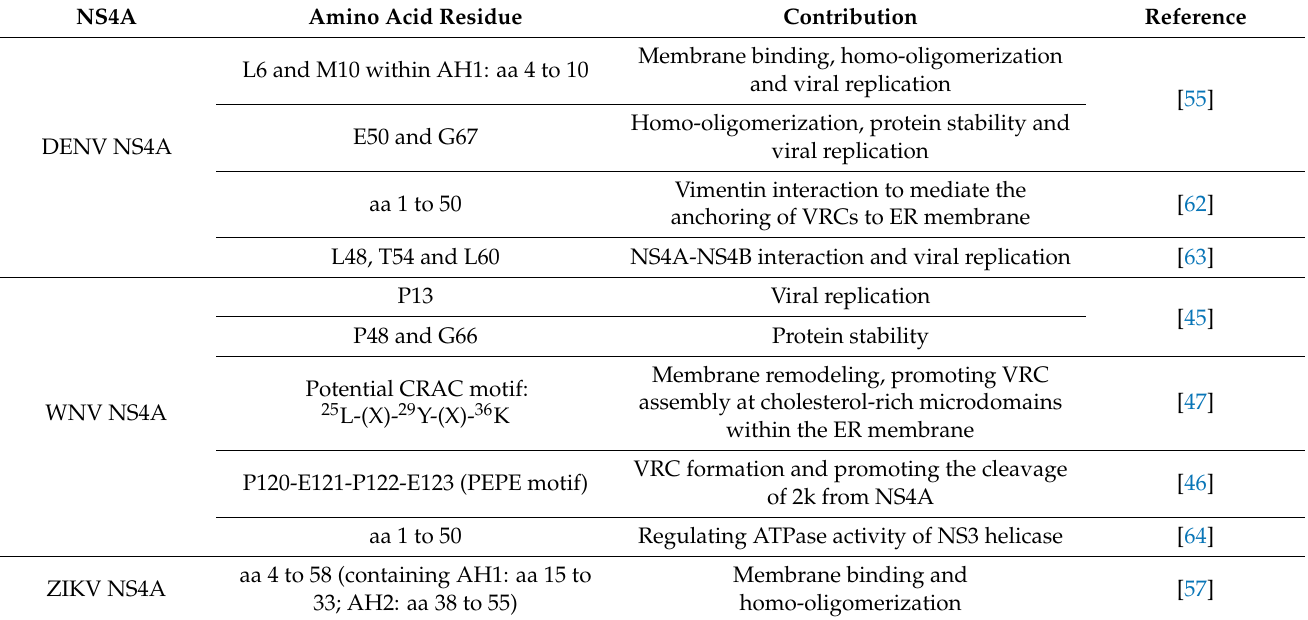
Table 1. Contributions of specific amino acid residues within flavivirus NS4As to viral